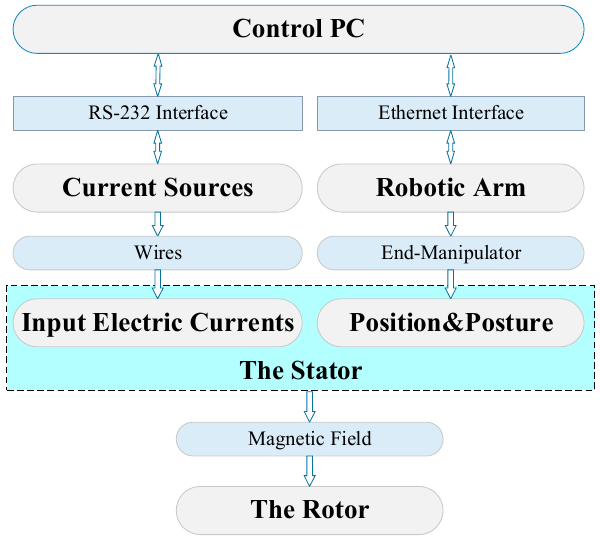
Figure 8. The physical structure of the experimental platform.